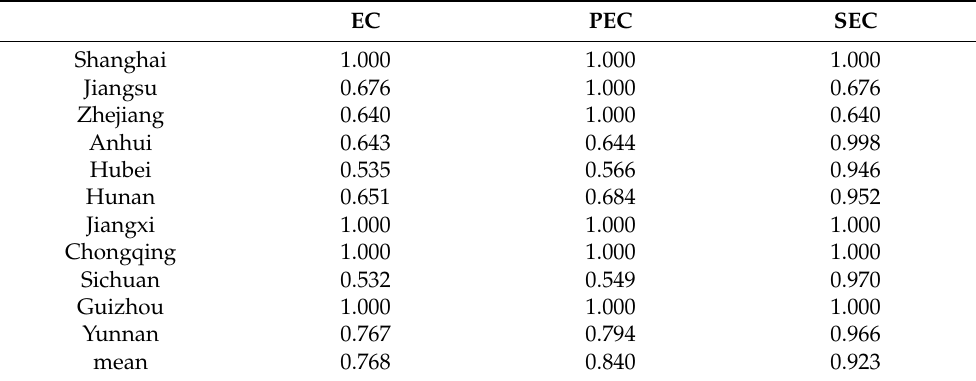
Table 6. Environmental governance efficiency of the YREB (Yangtze River Economic Belt).